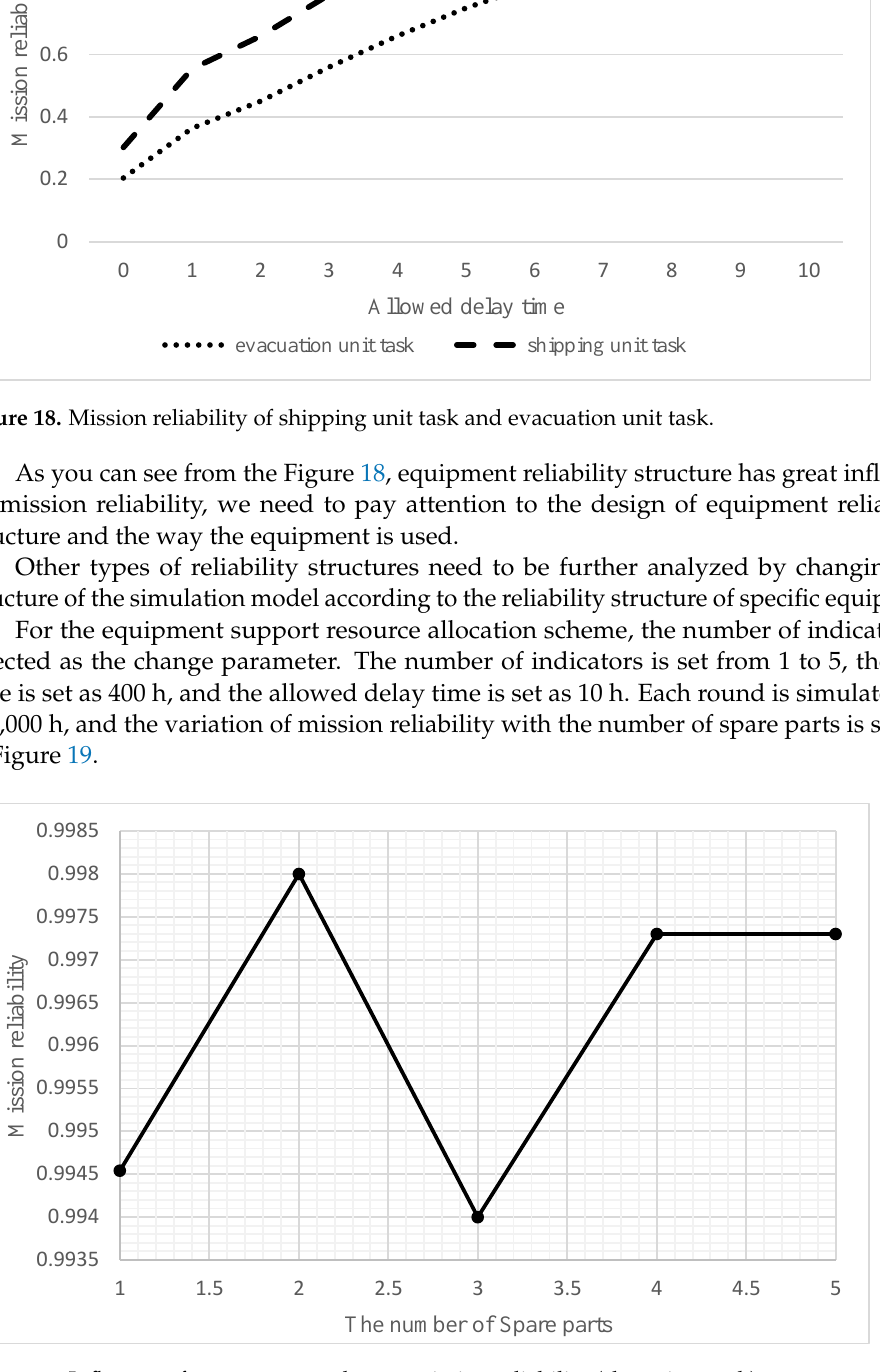
16 of 21 Figure 17. The mission reliability surface of the shipping unit task varies with the task parameters.